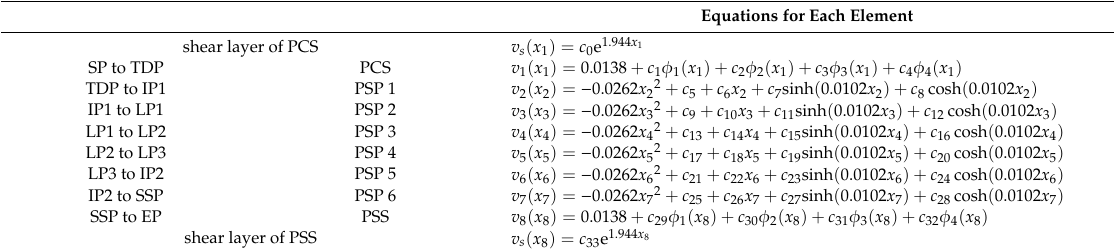
Table A1. The equations for each element of the segmental pipeline model.